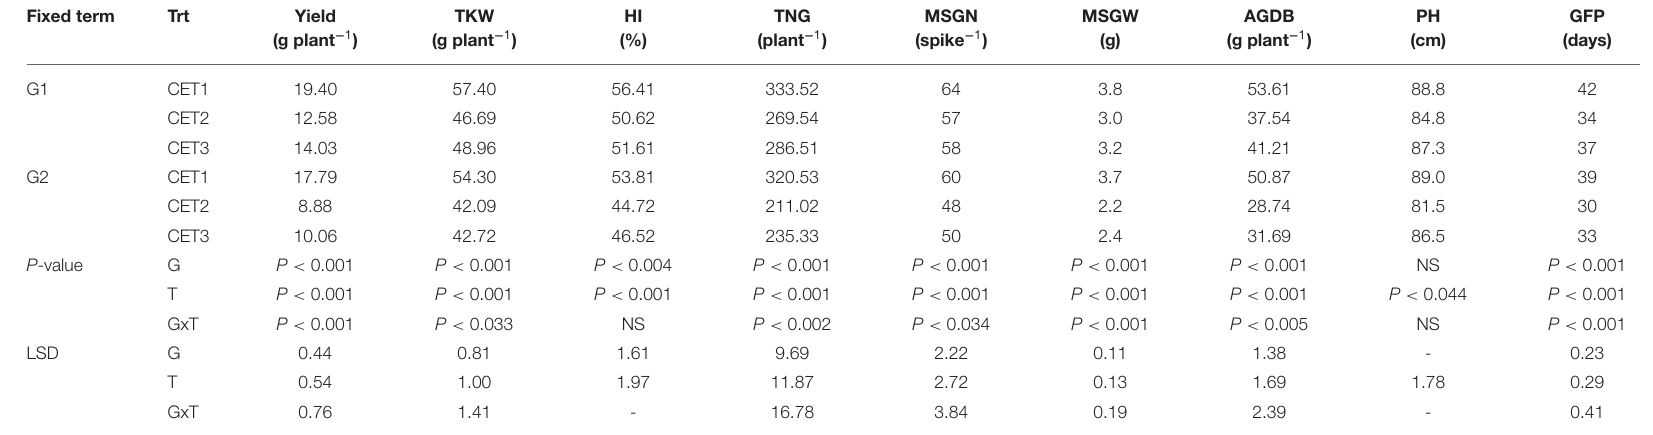
TABLE 2 | Phenological, morphological, yield, and yield component traits of the two wheat genotypes grown in a glasshouse under ambient conditions (CET1) or exposed to high temperature from heading (CET2) or anthesis (CET3) until maturity. Fixed